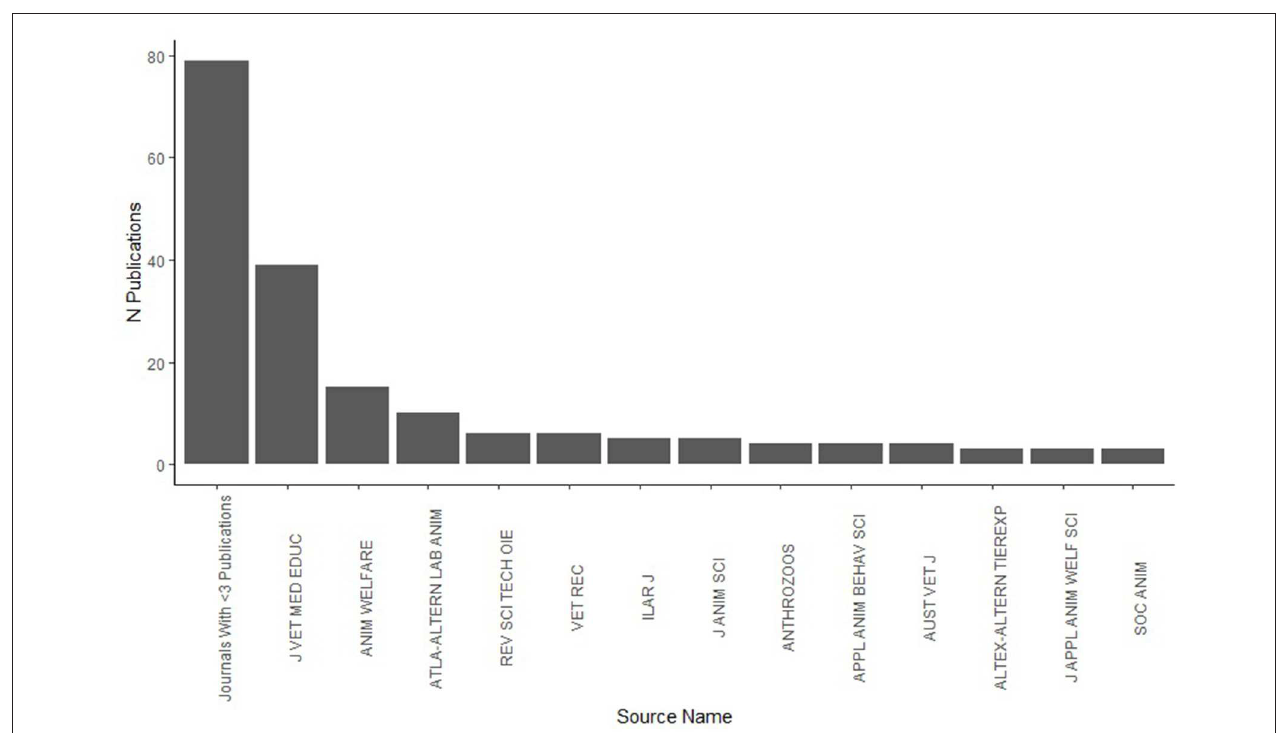
FIGURE 1 | Publications ( n = 188) by source title in Web of Science Search. Topic Boolean search string: “Animal Welfare” and “Education”.